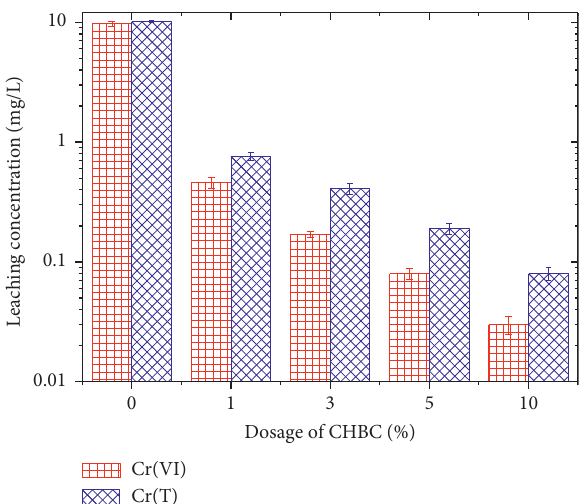
Figure 6: Effect of CHBC dosage on bioaccessibility of Cr and Cr(VI) of stabilized soils.